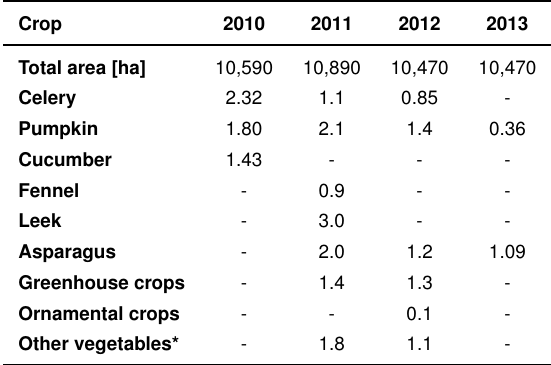
Table 9. Average copper application rates [pure copper kg ha − 1 ] in organic vegetable-growing in 2010 to 2013 based on the size of the application area. Copper products are used in only about 2 to 4% of the total cultivated area of the Bioland and Naturland